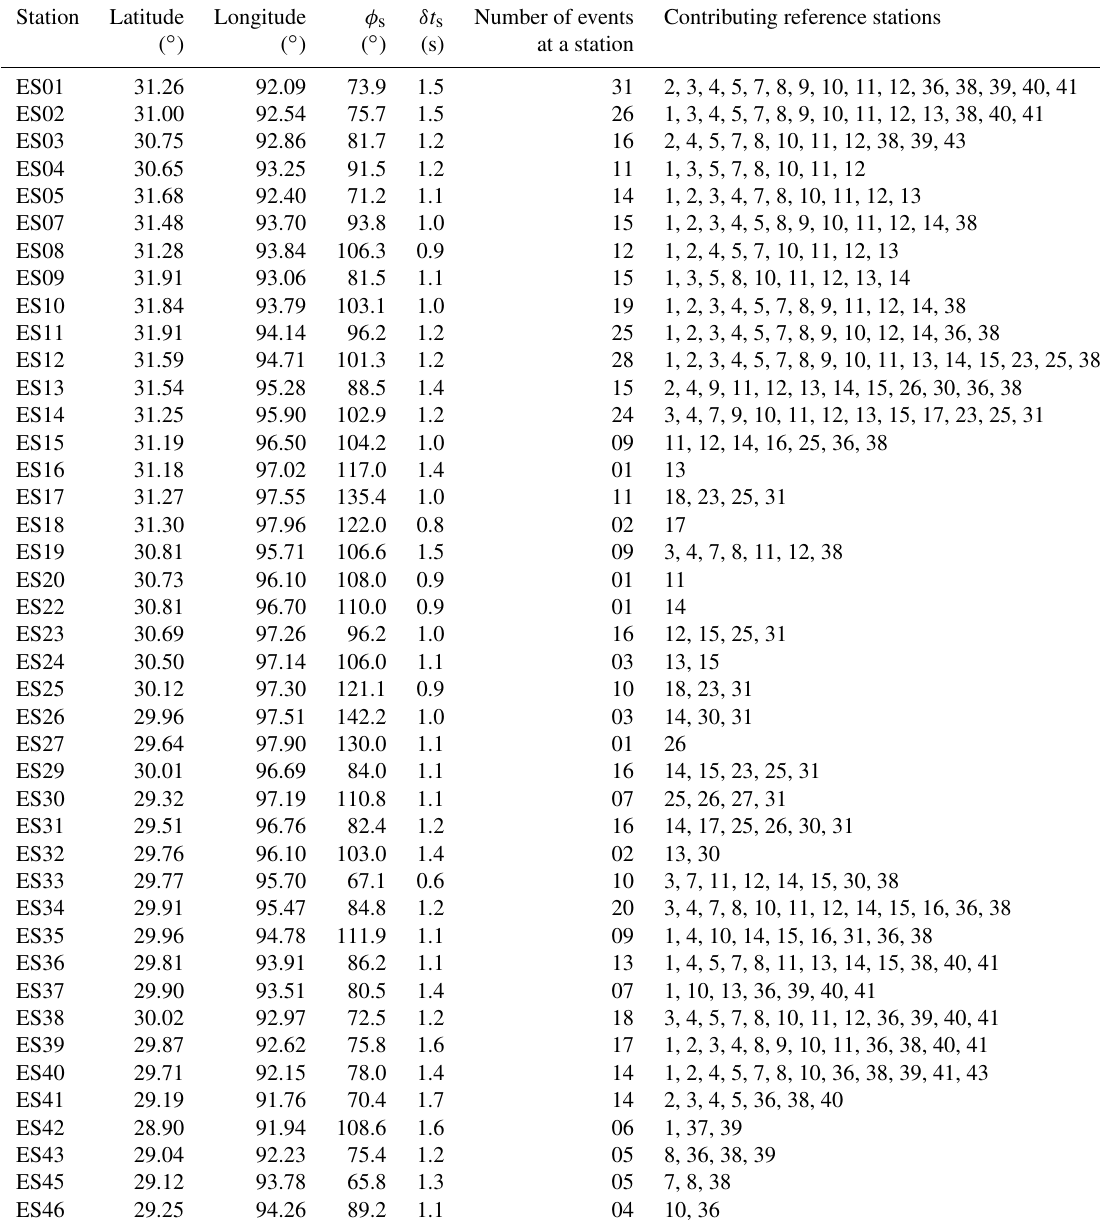
Table 2. Obtained average splitting parameters ( φ s and δt s ) estimated from direct S wave splitting measurement. Station Latitude Longitude φ s δt s Number of events Contributing reference